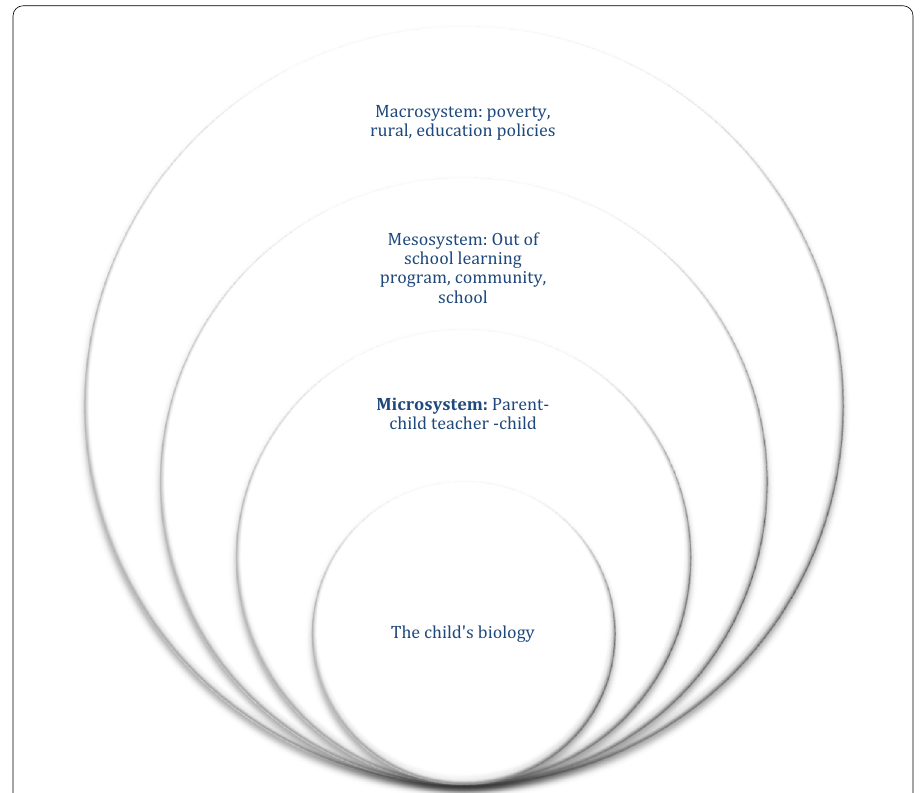
Fig. 1 An adaptation of Bronfenbrenner’s ecological systems